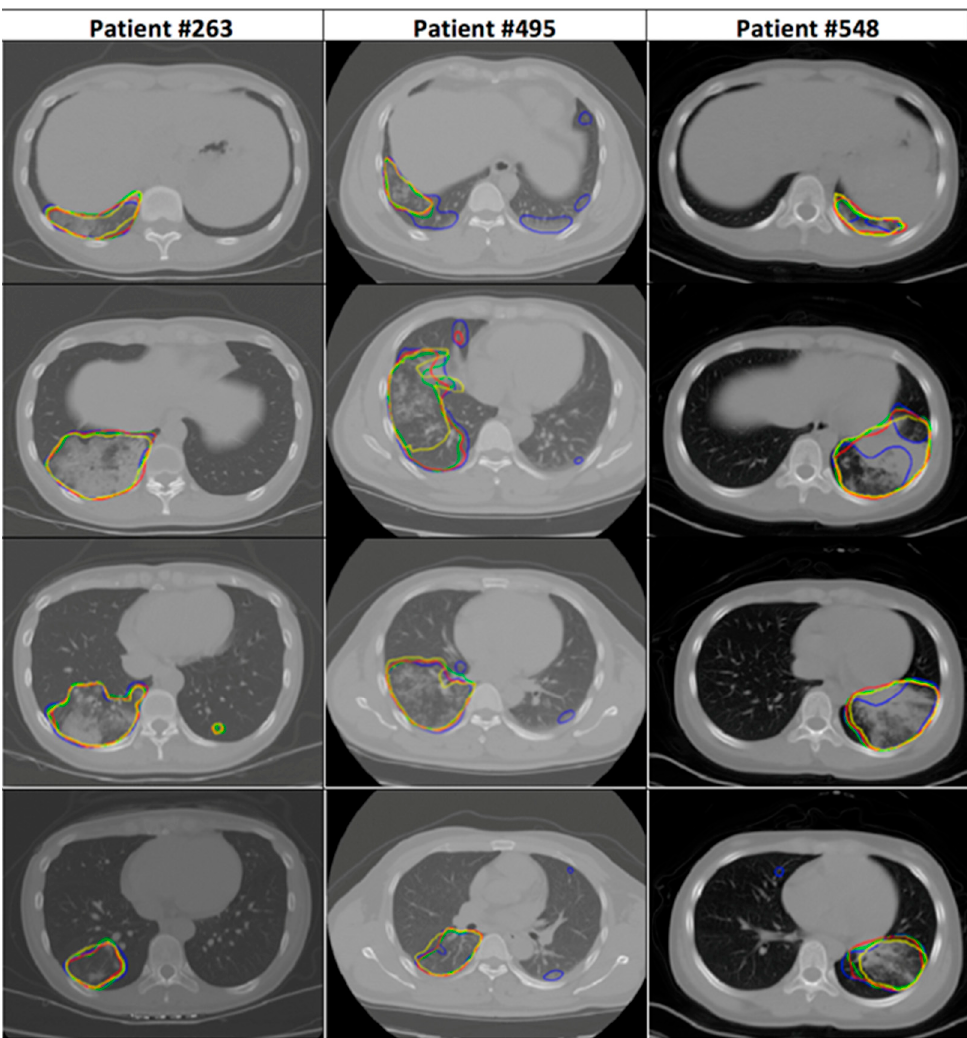
Figure 3. DSC-based boxplots of the different DL networks.